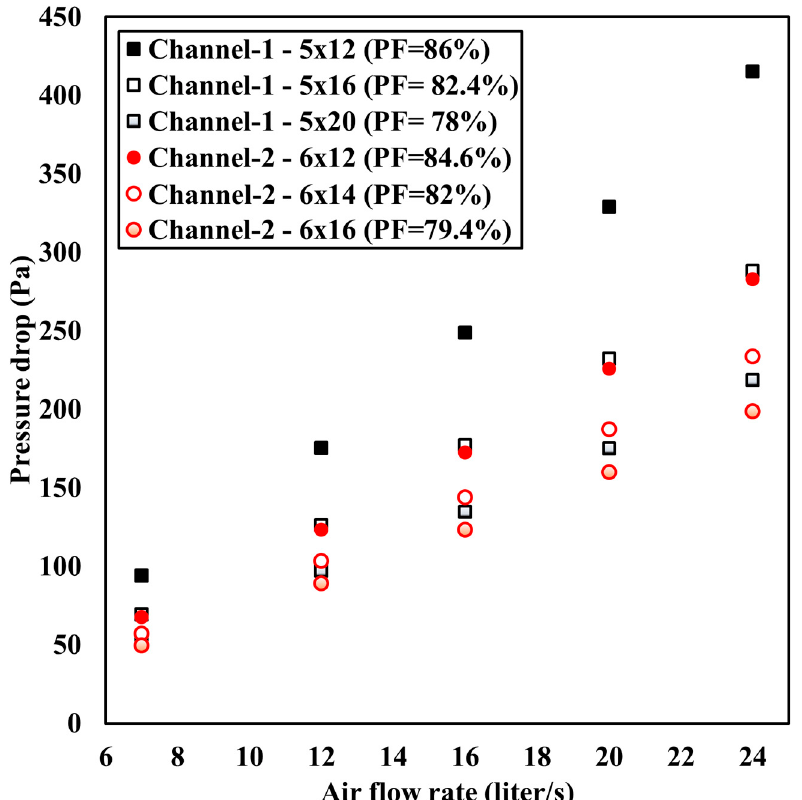
Figure 12. Pressure drop as a function of total air flow rate.